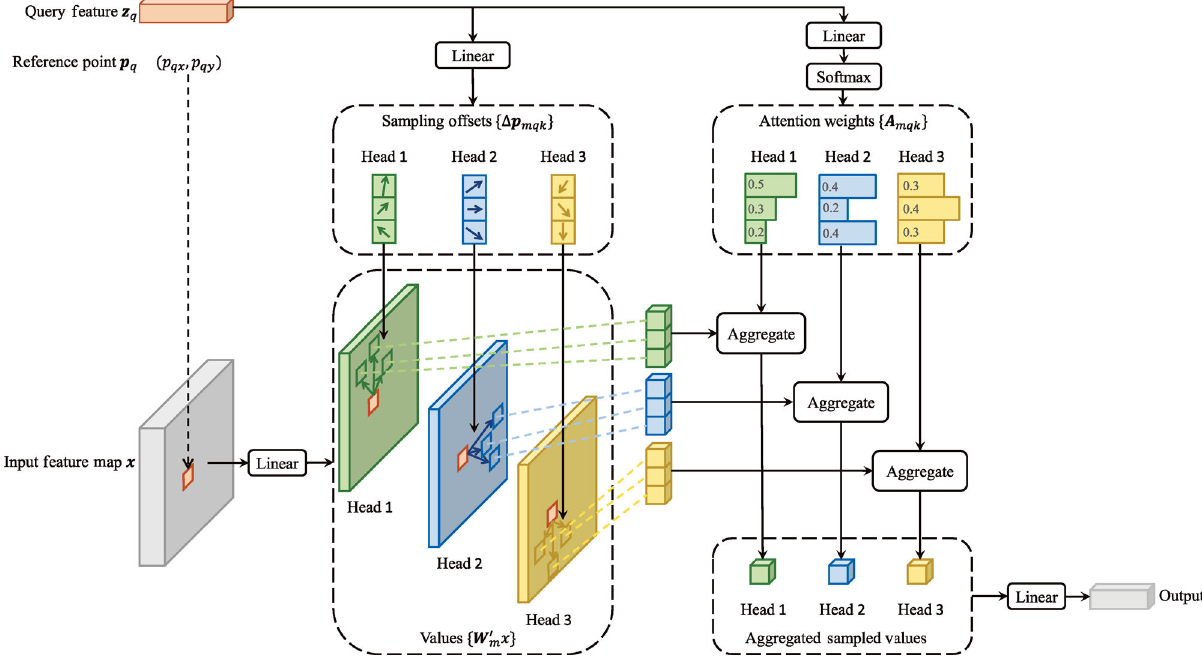
Fig. 10 Deformable attention module. Reproduced with permission from Ref. [25], c (cid:2) The Author(s)